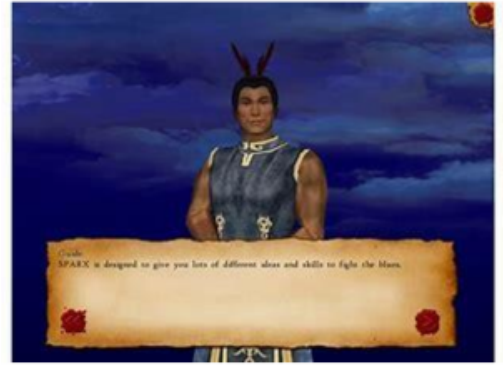
Figure 2. Guide characters in the SPARX original (left) and Japanese (right)